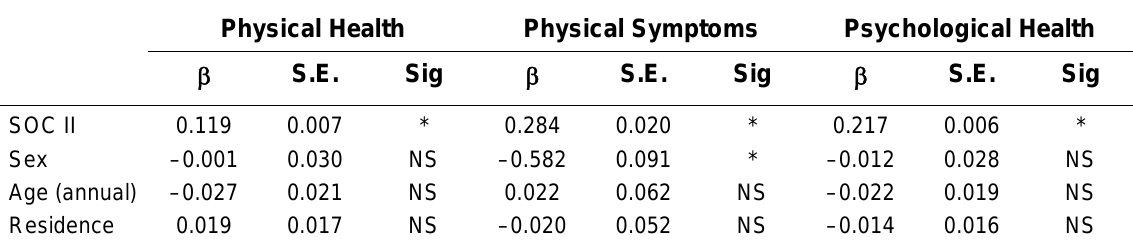
Model 1 (Demographic Variables), Linear Regression Analysis with Health as the Dependent